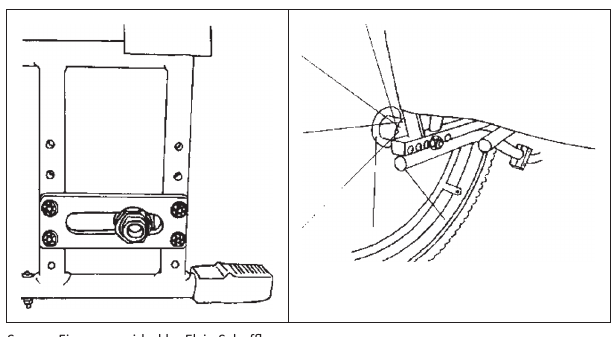
Source : Figure provided by Elsje Scheffler. FIGURE 6: Examples of design options with adjustable rear wheel axle settings.